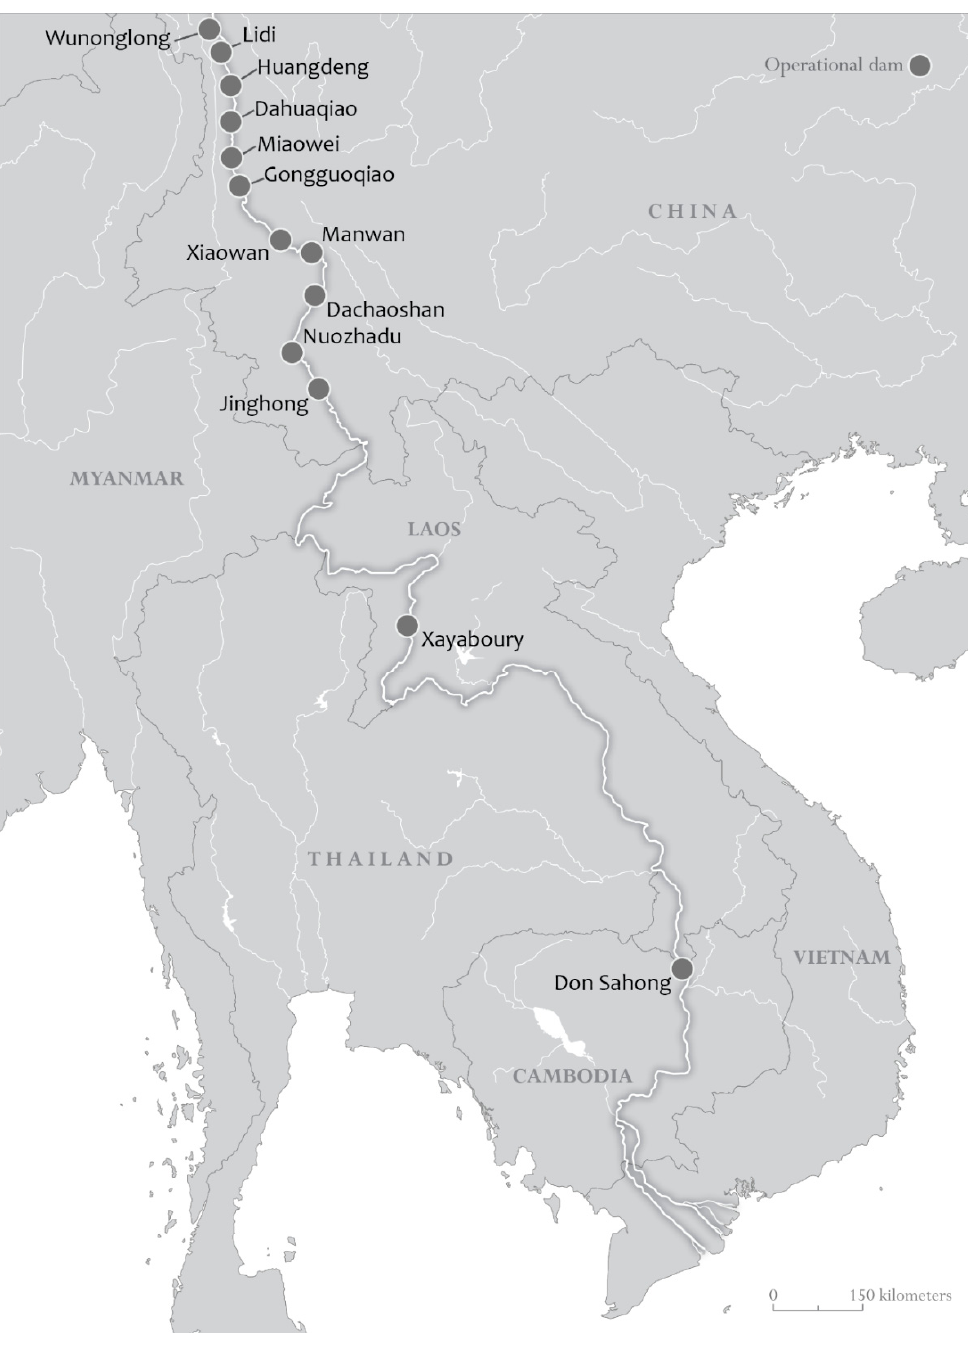
Figure 4. The Mekong River Basin, including hydropower dams built on the mainstream Mekong/Lancang River in China and Laos.